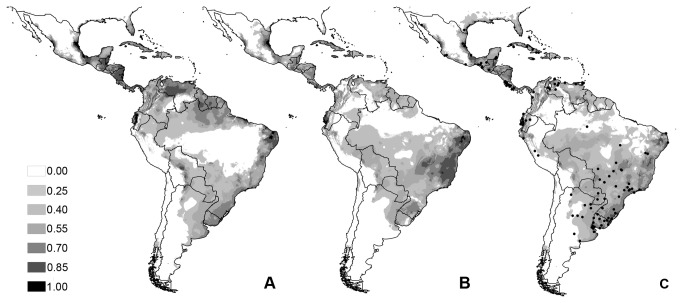
Maxent models for the potential distribution of C. hominivorax.A: Last Inter Glacial (LIG) conditions; B: The average Last Glacial Maximum (LGM) conditions for the CCSM and MIROC models; C: Present conditions (black points are geo-referenced sampling locations used for modeling). Maps are plotted with threshold of 0.25 in all of the analyses.